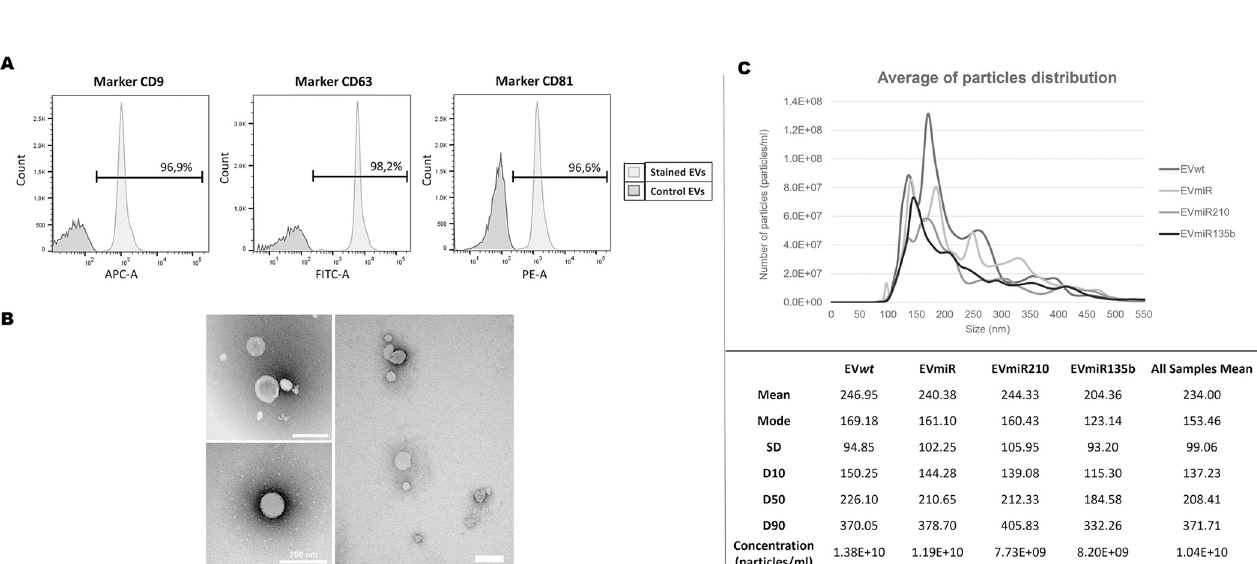
PLOS ONE | https://doi.org/10.1371/journal.pone.0272962 August 16,